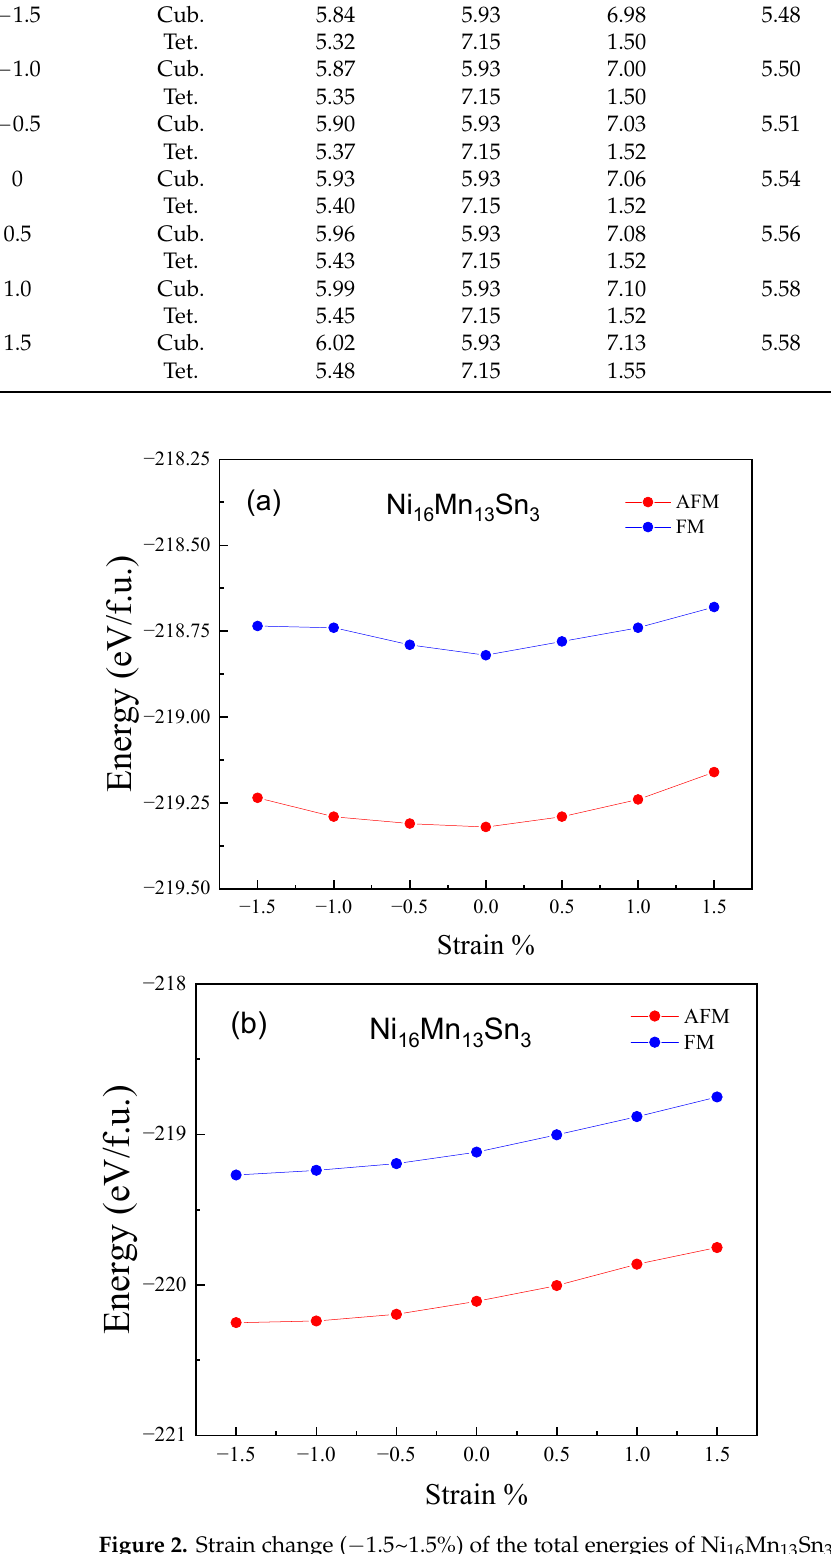
Figure 2. Strain change ( − 1.5~1.5%) of the total energies of Ni 16 Mn 13 Sn 3 alloys. ( a ) the austenitic phase. ( b ) the martensitic phase.